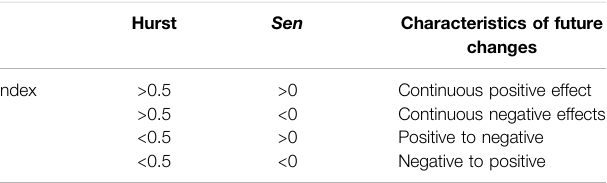
TABLE1| Sen ’ strendandtheHurstindexillustratingfuturechangestovegetation cover by anthropogenic effects.